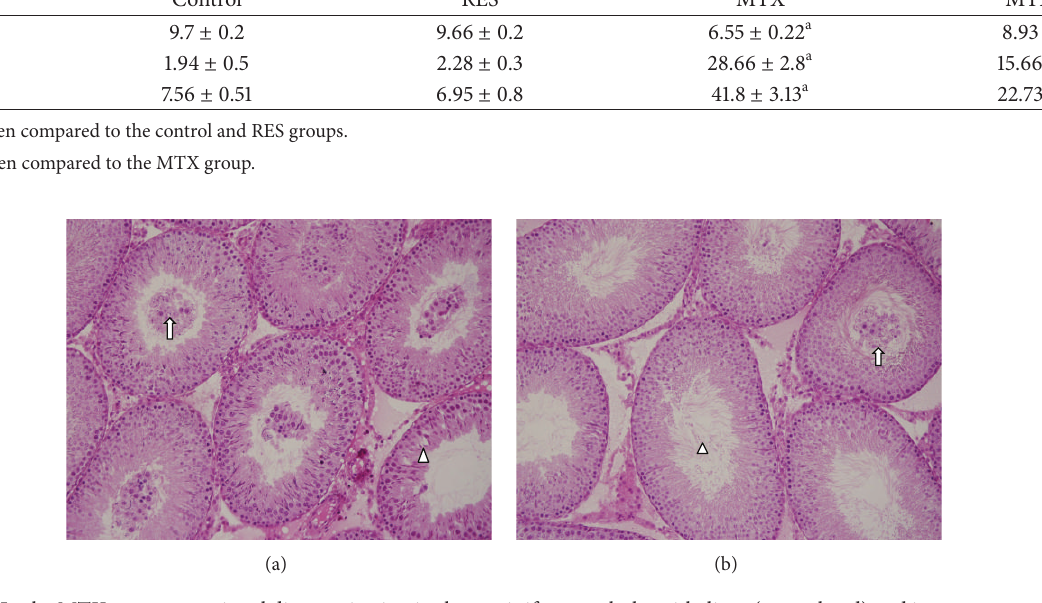
Dual comparisons between groups exhibiting significant val- ues were evaluated using the Bonferroni corrected Mann- Whitney 𝑈 test. Statistical significance for all tests was set at 𝑃 < 0.05 . All results were expressed as means ( ± ) standard deviation